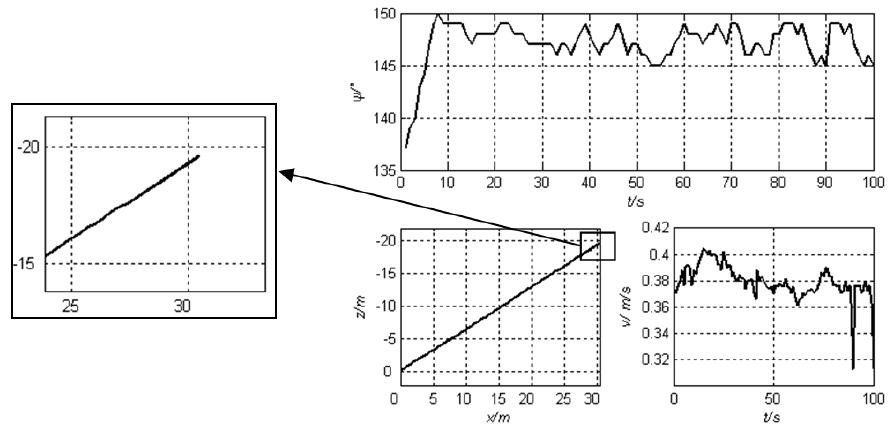
Figure 29. Lateral moving.